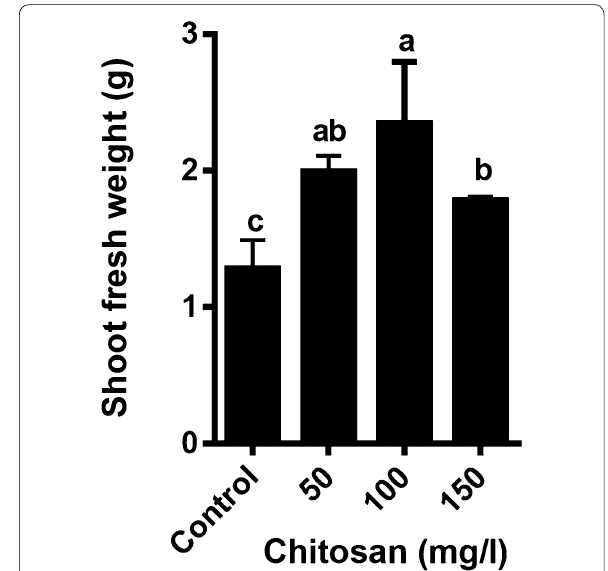
Fig. 1 Effect of chitosan levels on SFW of Melissa officinalis shoot cultures. Each value is expressed as mean Differences were significant at p < 0.05 level (one-way ANOVA followed by LSD